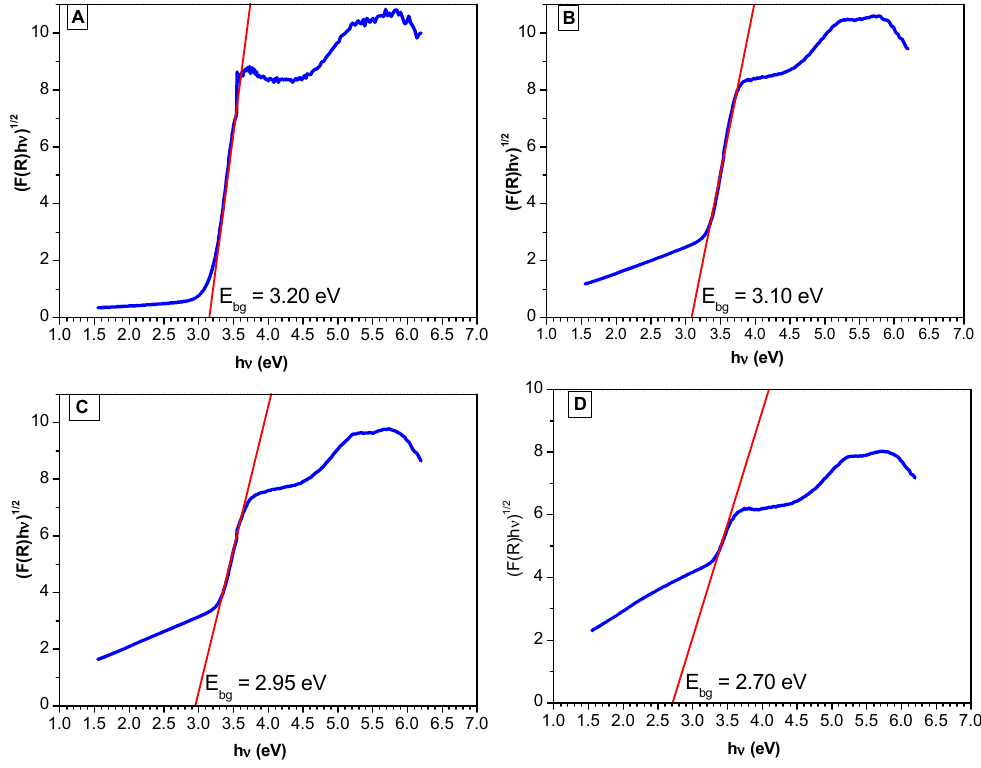
Figure 6. Tauc Plots for sol-gel A based TiO 2 photocatalysts calcined at 450 °C: ( A ) TiO 2 sol-gel A; ( B ) TiO 2 sol-gel A with 0.42 wt. % Pt; ( C ) TiO 2 sol-gel A with 0.82 wt. % Pt; ( D ) TiO 2 sol-gel A with 1.70 wt. % Pt. E bg was calculated using the intersection of Tauc’s line with the abscise axis; ( α hv ) 1 2 ≈ hv − E bg . Note: The Tauc plots for sol-gel B were reported in our previous paper